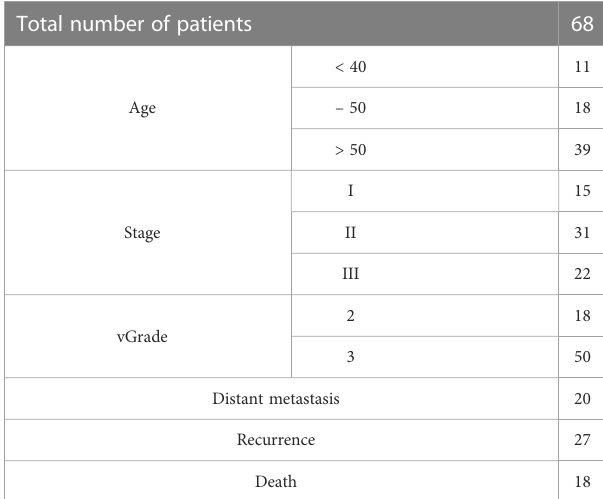
TABLE 1 Information of